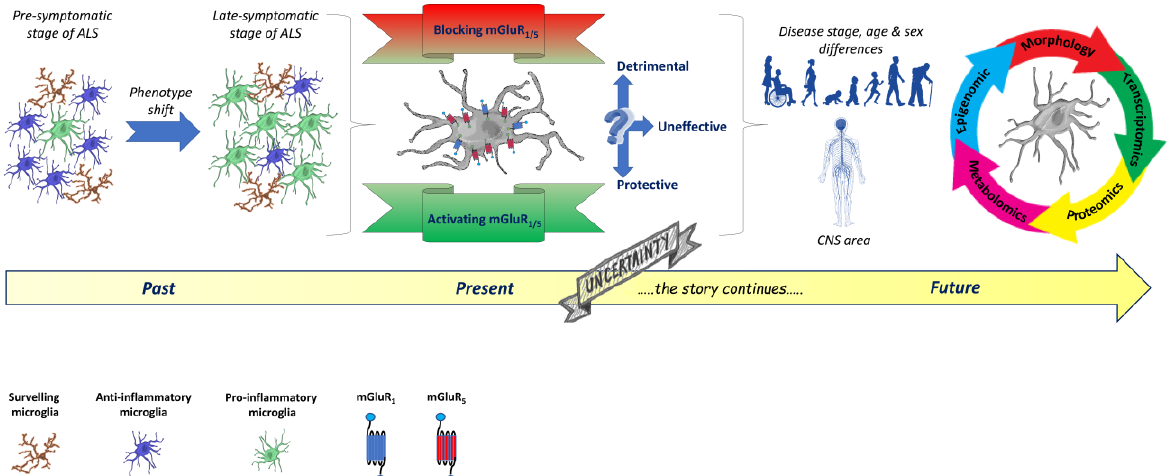
Figure 2. Past, present, and future perspectives to be further investigated in dissecting the role of mGluRs in the modulation of microglia phenotype changes during ALS